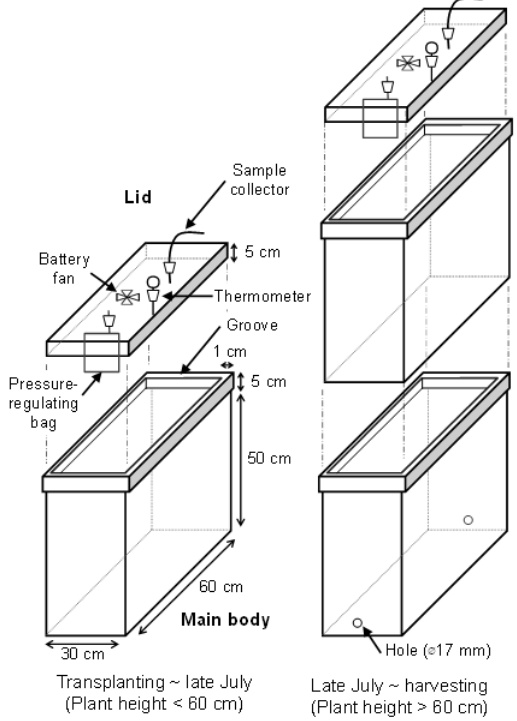
Figure 2. Schematic of the chamber used in this study.